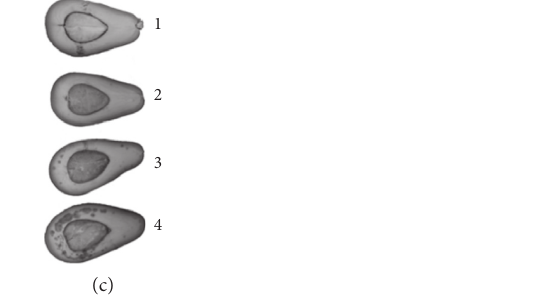
Figure 3: (a) Incidence of pulp spot in “Fuerte” avocado immediately after 30 and 50 days at 5 ° C. (b) Severity, expressed as percentage by category, in fruit stored after for 30 or 50 days at 5 ° C under RA. (c) Hedonic scale (1–4): 1, no occurrence; 2, slight; 3, moderate; 4, severe. Different letters within each storage period and treatment represent significant differences at P ≤ 0.05 as determined by the LSD test. d: days.